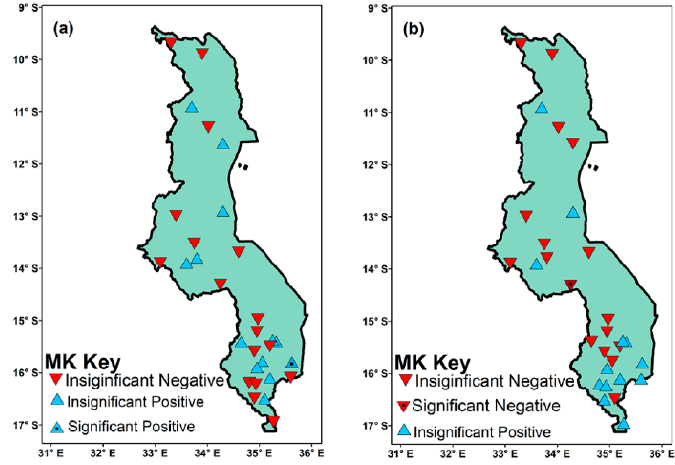
Figure 9. Spatial distributions of trends in ( a ) annual and ( b ) seasonal rainfall during 1979–2015 over Malawi. The red (blue) triangle shows the decreasing (increasing) trend. The triangles with black dots inside represent significant trends at the 95% confidence level. Table 3. Summary of MK results for annual and seasonal rainfalls over Malawi during 1979–2015.